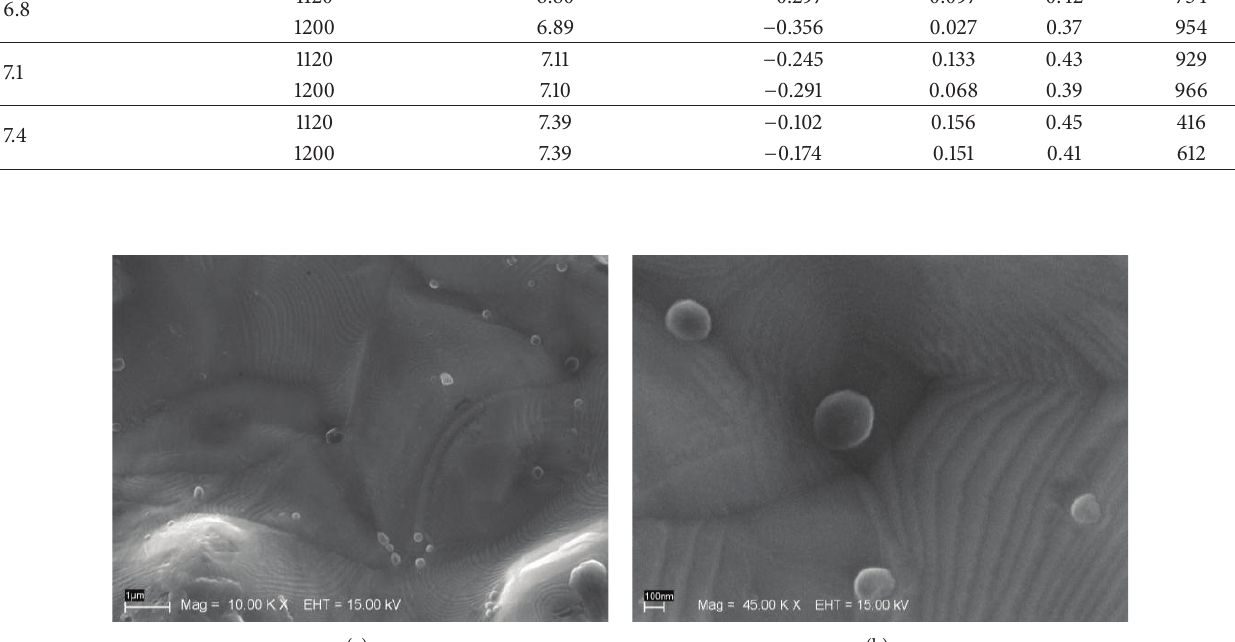
spectroscopy analysis as was reported by Danninger et al. [31–